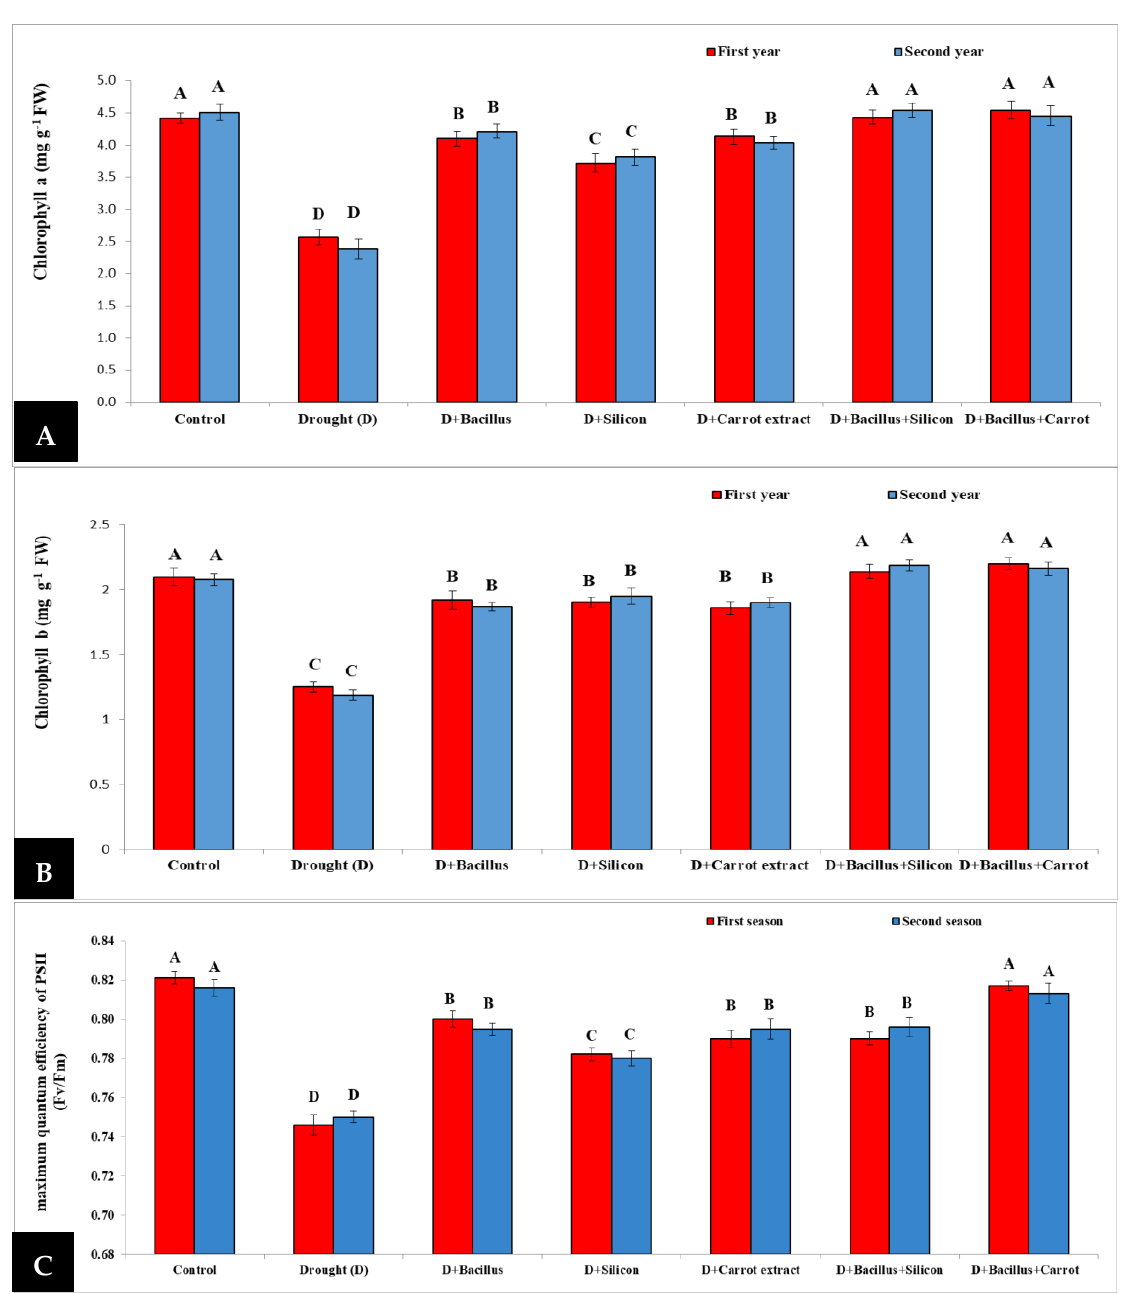
Figure 4. Effect of Bacillus thuringiensis , silicon and carrot extract on chlorophyll a ( A ), chlorophyll b ( B ) and maximum quantum efficiency of PS II ( C ) of drought-stressed pea plants during 2019/2020 and 2020/2021 seasons. Different letters on the columns show significant differences between the treatments according to ANOVA, and Duncan ’ s post hoc test when the result of the omnibus multivariate F-test in ANOVA was significant ( p ≤ 0.05). Data is the mean (± SE) of five replicates.